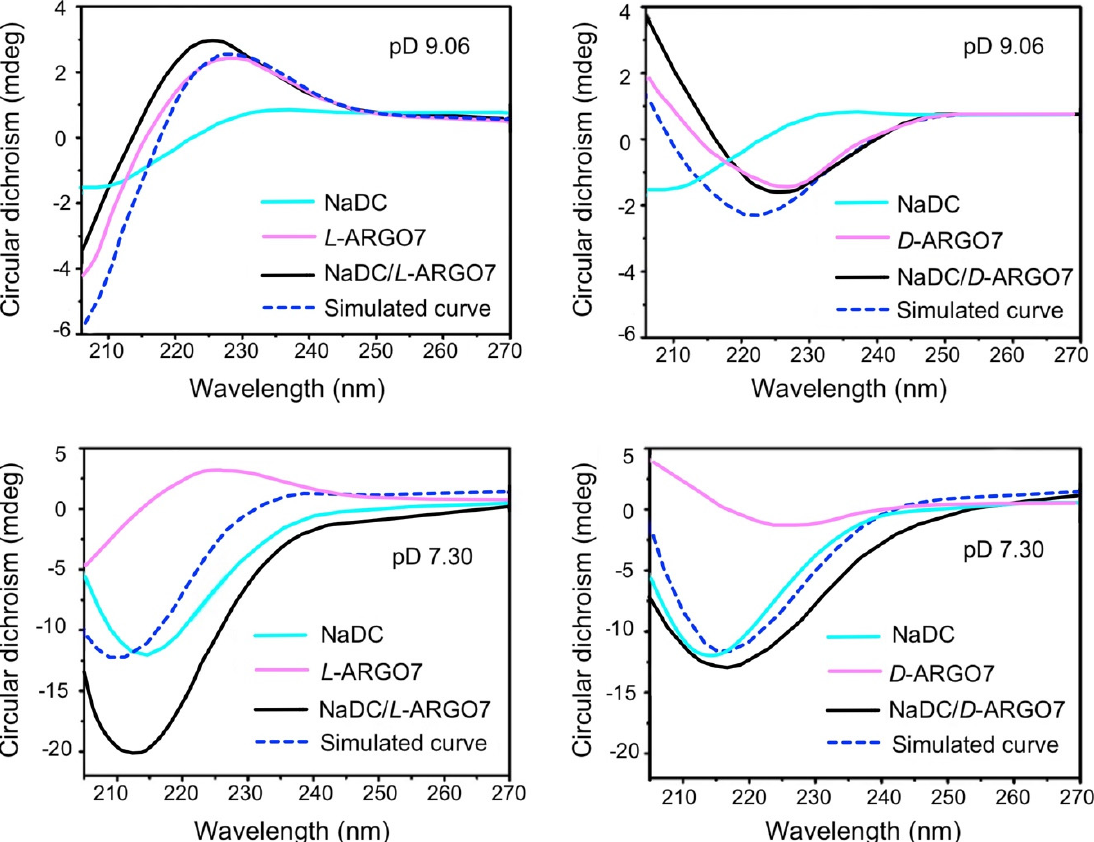
Figure 1. Comparison between the simulated and experimental circular dichroism (CD) spectra of NaDC / D 2 O / ARGO7 isomer mixtures at pD 7.30 and 9.06. Experimental conditions: NaDC concentration 5 mg mL –1 ; ARGO7 concentration 0.5 mg mL –1 ; temperature 25 °C; optical path 1 mm.